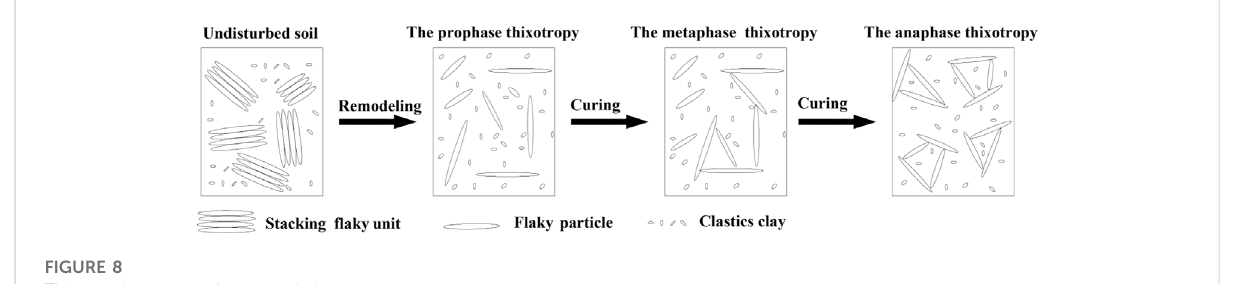
FIGURE 8 Thixotropic pattern of structural clay.